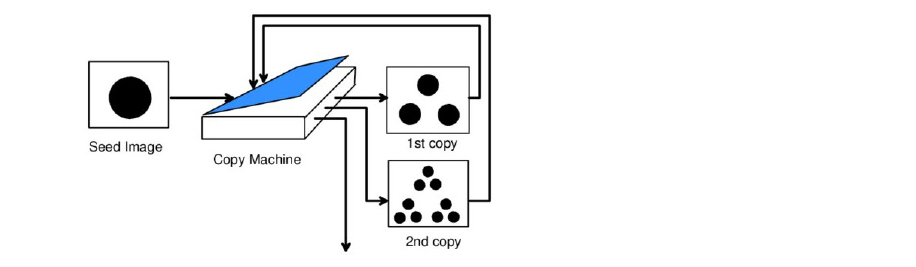
Figure 29. A Multiple Reduction Copying Machine (MRCM) with sample outputs. Reprinted with permission from [47]. Copyright 1997 Springer.